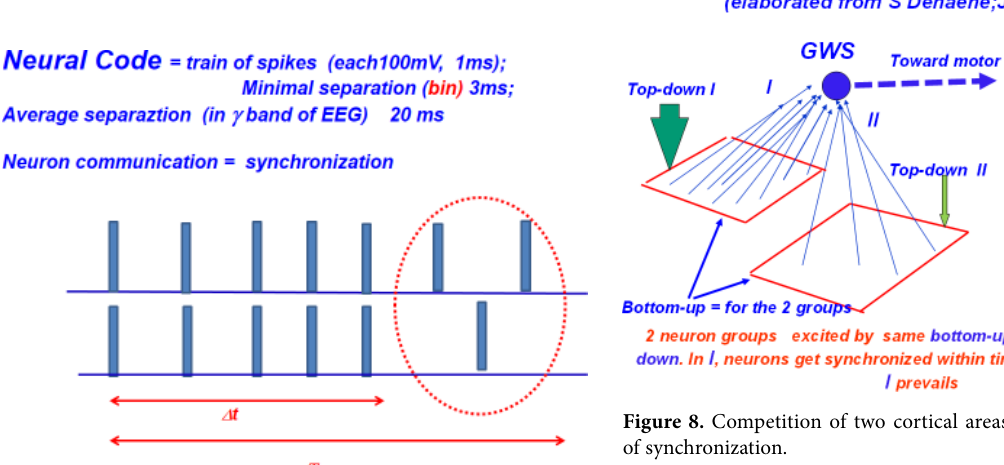
Figure 5. Homoclinic chaos; the dynamic trajectory is a closed orbit starting from S (saddle point) and returning to it. Projecting on a single direction, we observe spikes P repeating in time. The time separation between two spike occurrences depends on the relations between α and g, thus it can be controlled by a voltage applied to S, as the signal χ.